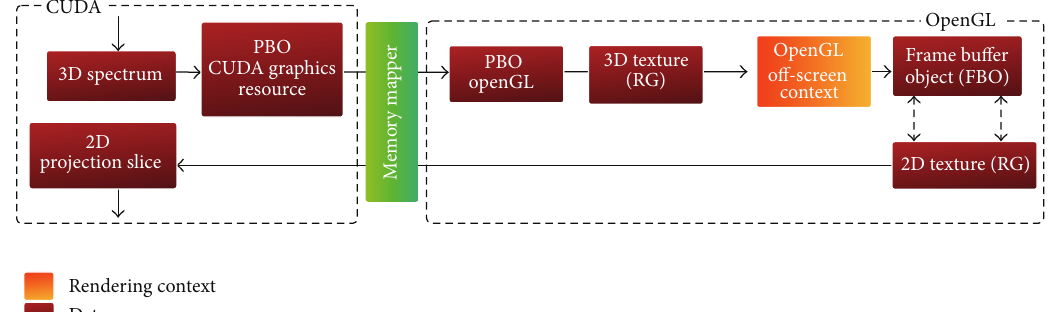
Figure 6: Communication between CUDA and OpenGL off-screen rendering contexts. The spectral volume is mapped between the two contexts via PBOs and the projection-slice is mapped to a 2D texture via CUDA array.